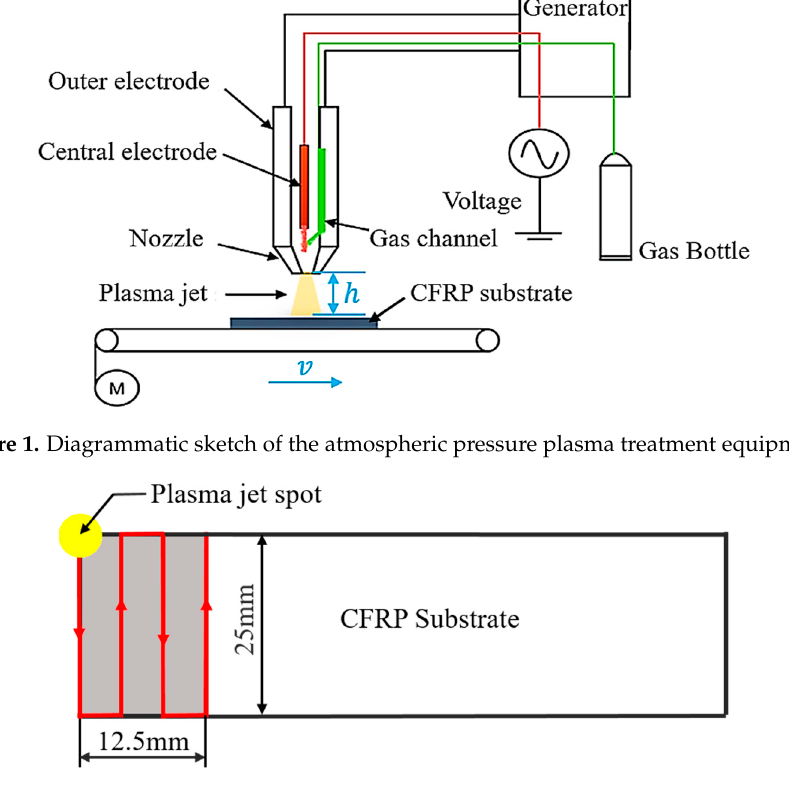
Figure 2. Illustration of the relative motion path between plasma jet and carbon fiber reinforced polymers (CFRP) substrate.